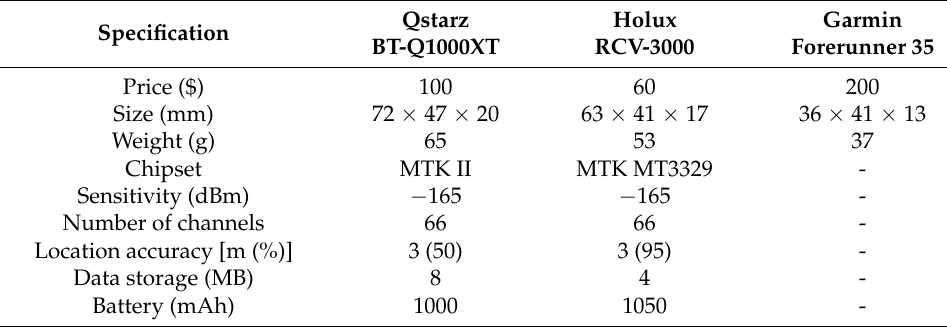
Figure 10. Smart watch Garmin Forerunner 35.